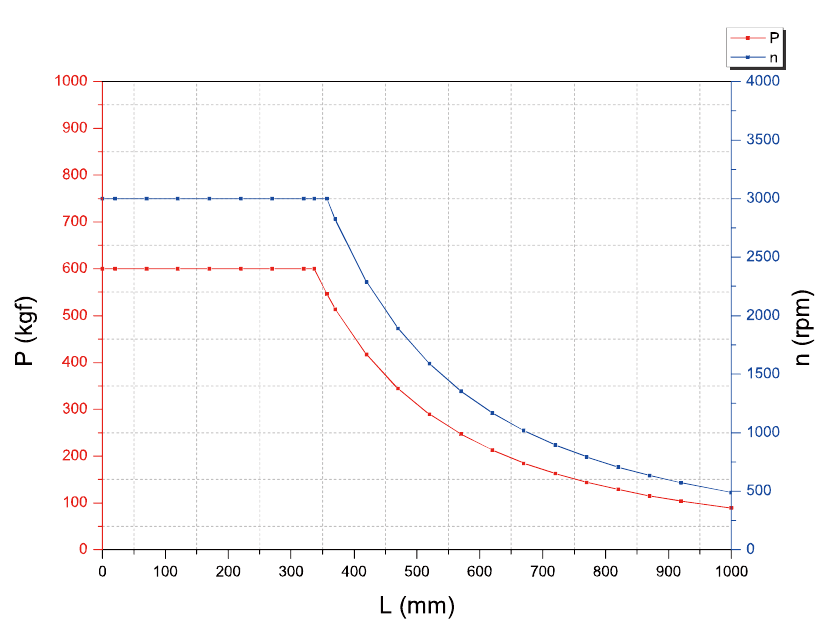
Figure 3. Relationship curve of rated stroke, load and rotation rate of electric linear actuator.